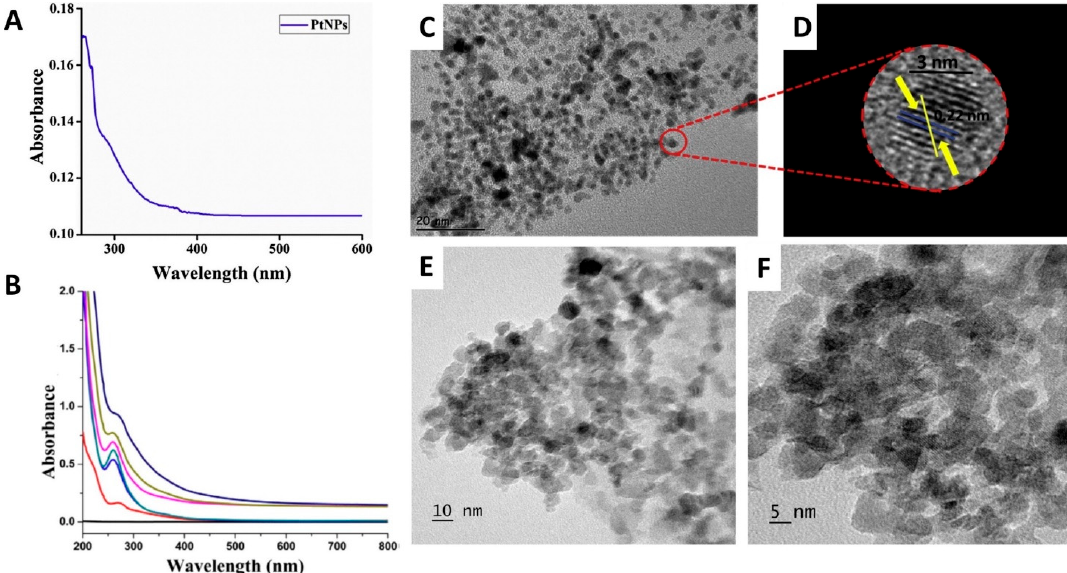
Figure 2. Characterization of PtNPs phytosynthesized utilizing plant extracts using